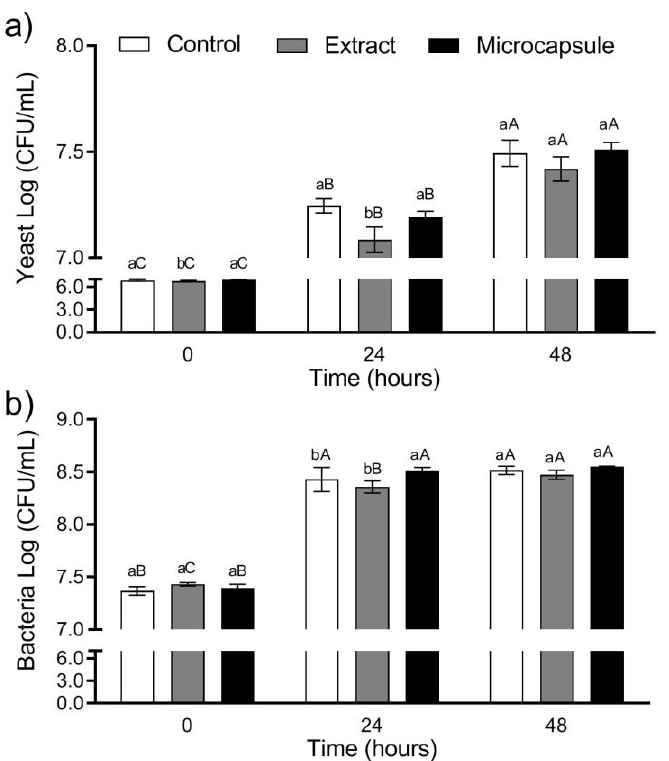
Figure 2. Microbial population during fermentation. ( a ) Yeast population. ( b ) L.A.B. population. Different lowercase letters denote differences ( p < 0.05) among assays simultaneously. Different capital letters denote differences ( p < 0.05) in the same assay at different times according to the Scott–Knott test. [Non-dairy matrix (N-DM): 1 Control—consists only of the fermented beverage (N-DM); 2 Extract—beverage (N-DM) with propolis extract (DPE); 3 Microcapsule—beverage (N-DM) with microencapsulated propolis (D.M.P.)].